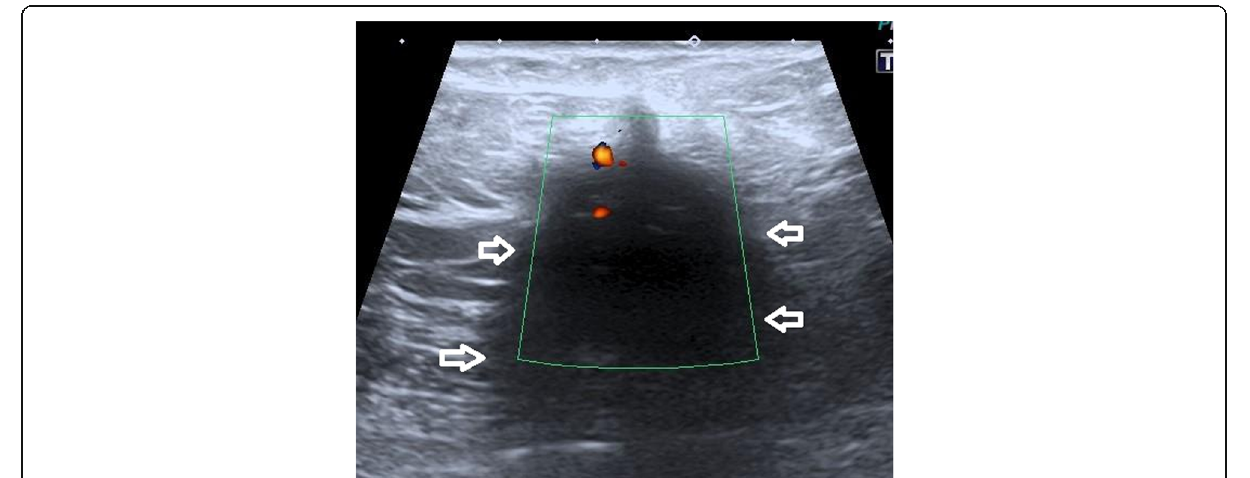
Fig. 6 A color Doppler image showing a hypoechoic left rectus abdominus muscle lesion (between the open white arrows) with peripheral vascularity for a 32-year-old female presenting left para-umbilical swelling that was histopathologically confirmed as an abdominal wall muscle